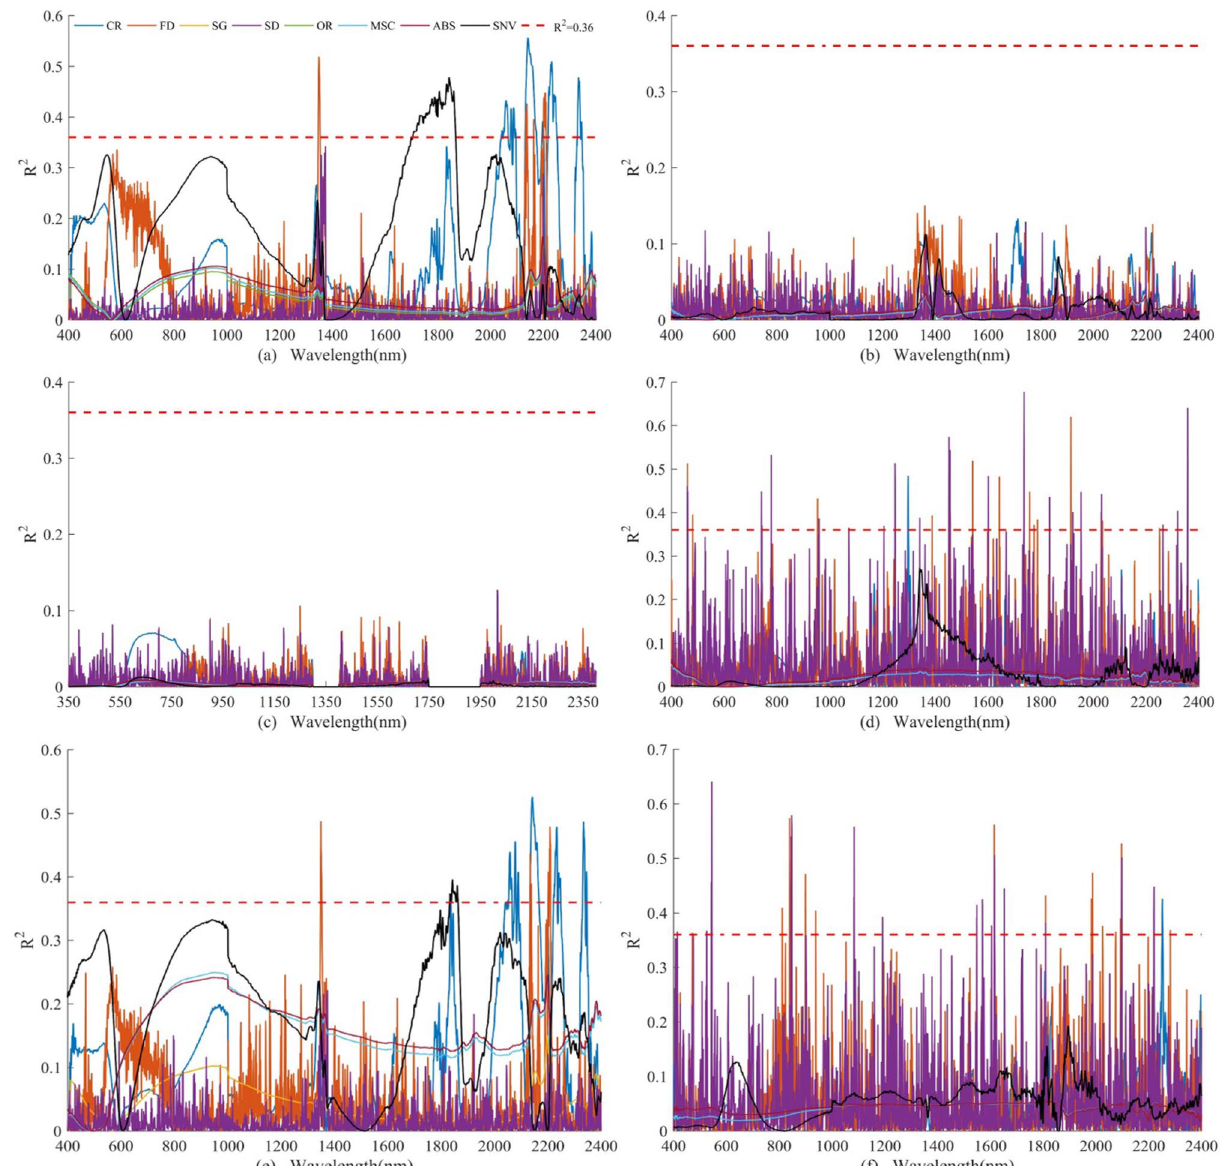
( d ): clean group (Zn ≤ 48.6 mg kg −1 ), ( e ): low pollution group (48.6 ≤ Zn ≤ 97.2 mg kg −1 ), and ( f ): moderate pollution group (97.2 ≤ Zn ≤ 145.8 mg kg −1 ). (Note: The spectral reflectance was measured after processing at the laboratory for the clean group, low pollution group, and moderate pollution